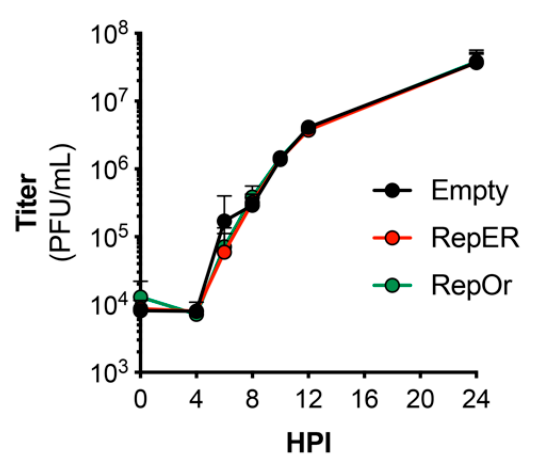
Figure 4. Growth kinetics of CVB in reporter expressing cells. U2OS cells transfected with the indicated expression plasmids were bound with CVB (100 PFU/cell) at 4 °C for 1 h, washed, and infection was allowed to proceed at 37 °C for 24 h. Plaque assays were performed on samples collected at the indicated time points. Data represents the average ± SD titer (plaque-forming units [PFU]/mL) from two independent experiments.